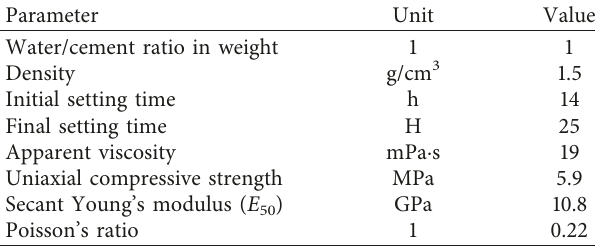
Table 3: Basic properties of cement material.